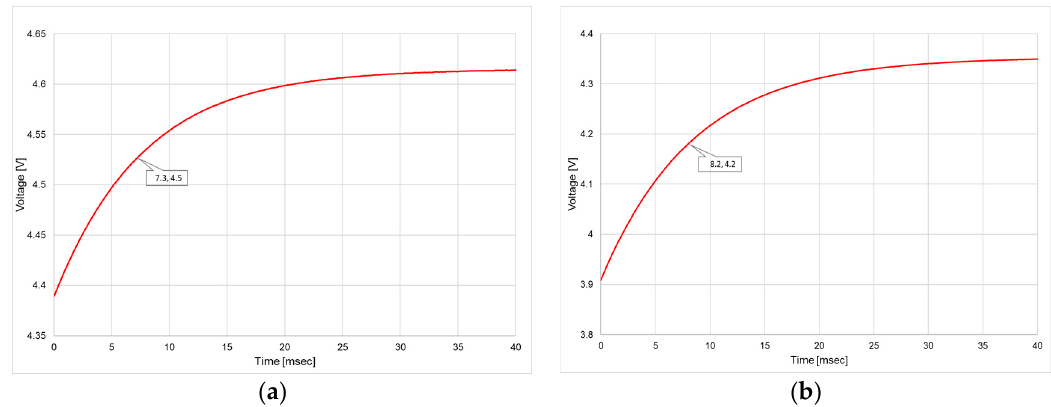
Figure 12. Transient simulation of the DUT (plate area 213.2 µm × 213.2 µm, arm width 6.4 µm and a gap of 18 µm), applied heater voltage of (cid:1848) (cid:3035)(cid:3032)(cid:3028)(cid:3047)(cid:3032)(cid:3045) = 5 V , and (cid:1844) (cid:3035)(cid:3032)(cid:3028)(cid:3047)(cid:3032)(cid:3045) = 1000 ohm . The thermal time constant is 5.25 msec.